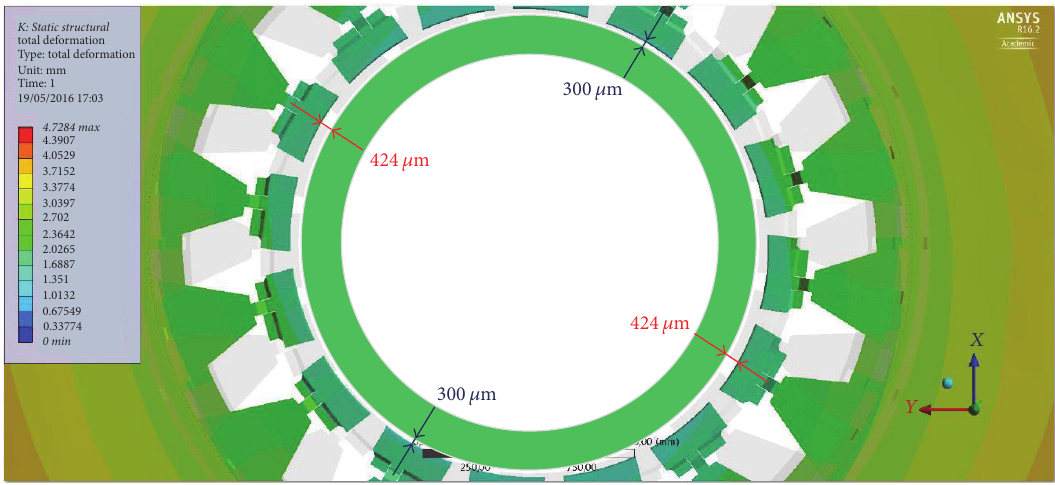
Figure 15: Elliptical deformation of the upper journal bearing bracket due to eddy currents created by the electromagnetic field of the generator outputs.